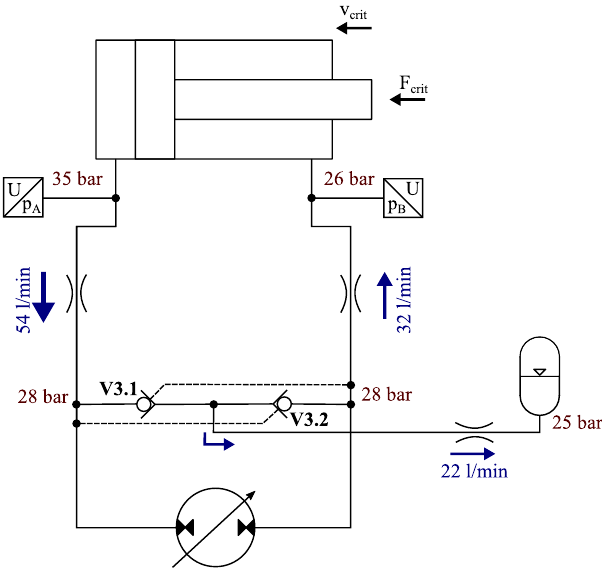
Figure 6. Critical load and speed condition while lowering the empty boom at which small changes in cylinder load or speed result in mode switching (ca. 30% of maximum lowering speed and 28 °C oil temperature); the two parallel cylinders are simplified as one cylinder, and the values are obtained from